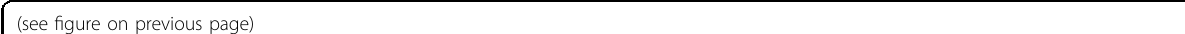
Fig. 2 CircRNA_2646 interacted with miR-124 in ESCC cells. A and B The expressions of miR-124 and CircRNA_2646 determined by RT-qPCR in human normal esophageal epithelial cells HEEC and ESCC cell lines (KYSE150, Eca109, TE-1, and Eca9706). C CircRNA_2646 was predicted to harbor the potential interaction sites of miR-124 by bioinformatics analysis. D Luciferase reporter assay indicated that CircRNA_2646 could interact with miR- 124 in Eca109 and TE-1 cells. E and F The expressions of CircRNA_2646 and miR-124 in Eca109 and TE-1 cells estimated by RT-qPCR after overexpression of CircRNA_2646 with or without miR-124 mimics transfection. G The proliferation and H , I viability of Eca109 and TE-1 cells determined by Edu and CCK-8 assay after relevant stimulation. *** p <